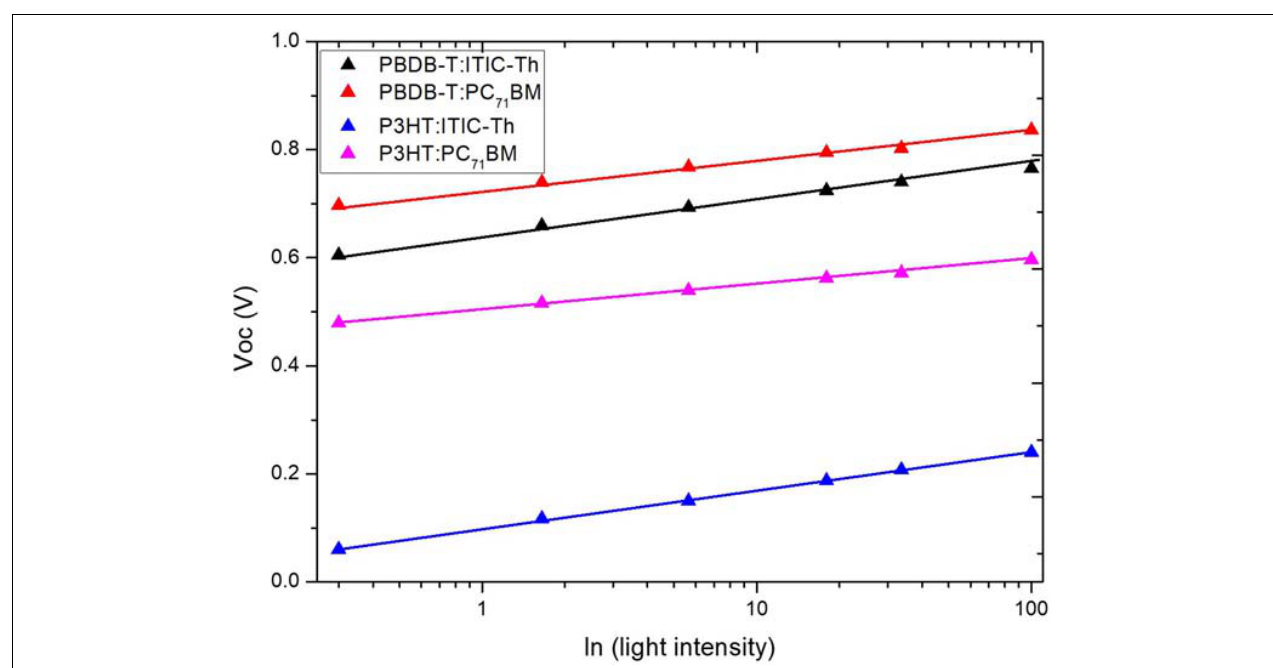
FIGURE 10 | Open-circuit voltage variation with Light intensity for various devices.